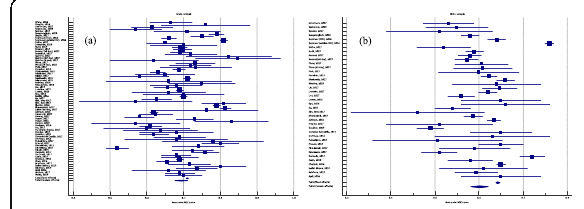
Fig. 1 (abstract P48). Forest plots of AUC for (a) qSOFA and (b) SIRS in predicting mortality